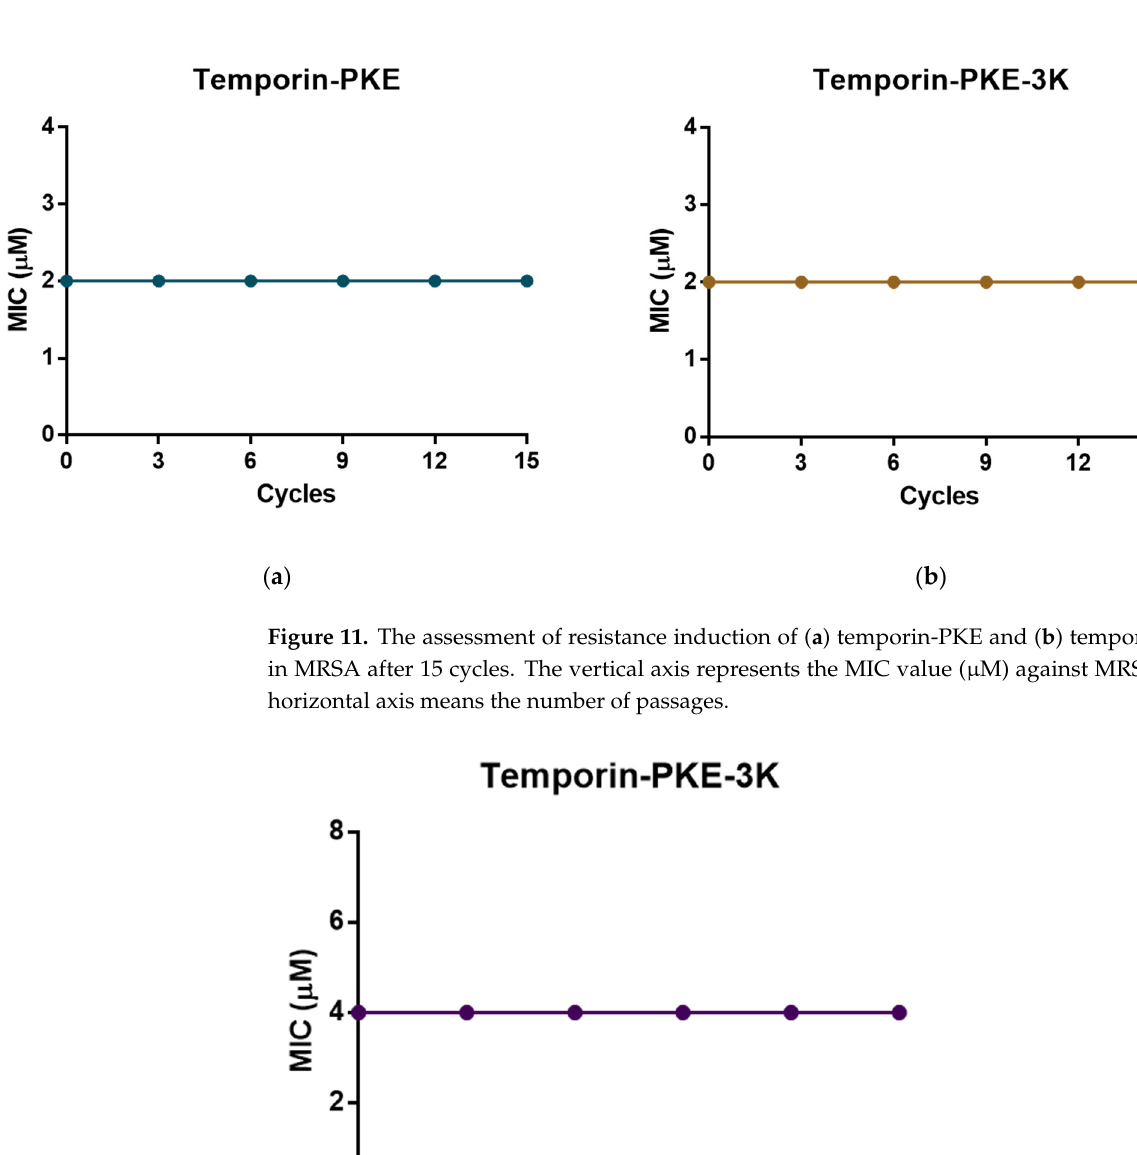
21 of 30 Figure 10. The anti-proliferation activity of temporin-PKE and its analogues against ( a ) HCT-116, ( b ) H838, ( c ) U251MG, ( d ) PC-3, and ( e ) H157 cells. PBS and 0.1% Triton X-100 were used as negative control and positive control, respectively. The results were analysed by two-way ANOVA and Dun- nett’s multiple comparisons test, which compared different concentrations of peptides with the neg- ative control group. The symbol **** indicates p < 0.0001. The error bar represents the SEM of the nine replicates in three tests (three replicates in each test). Table 9. The IC 50 values of temporin-PKE and its derivatives against several cancer cell lines. Cancer Cell Lines